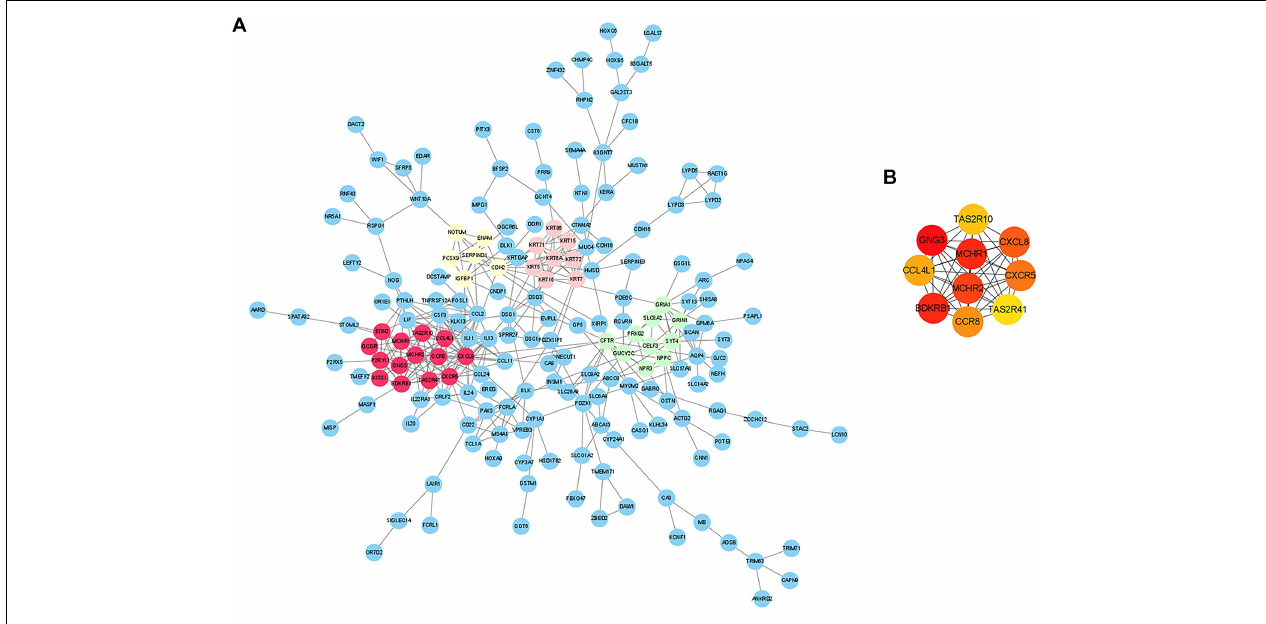
FIGURE 3 | Analysis of protein-protein interaction (PPI) network of CAD-related differentially expressed genes (DEGs) in EAT. (A) Edges represented protein-protein associations which were meant to be specific and meaningful. The colored nodes (red, green, pink, and yellow) represented the top four modules in the PPI network. (B) Top 10 hub genes identified by CytoHubba in Cytoscape.